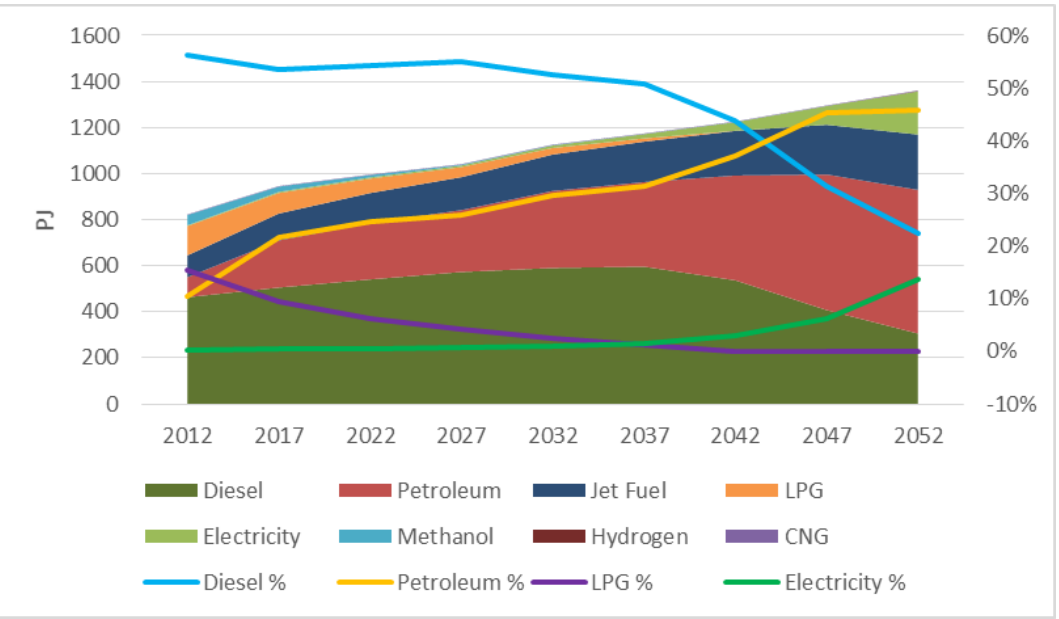
Figure 4. Energy consumption of the transport sector by fuel type: BASE scenario.